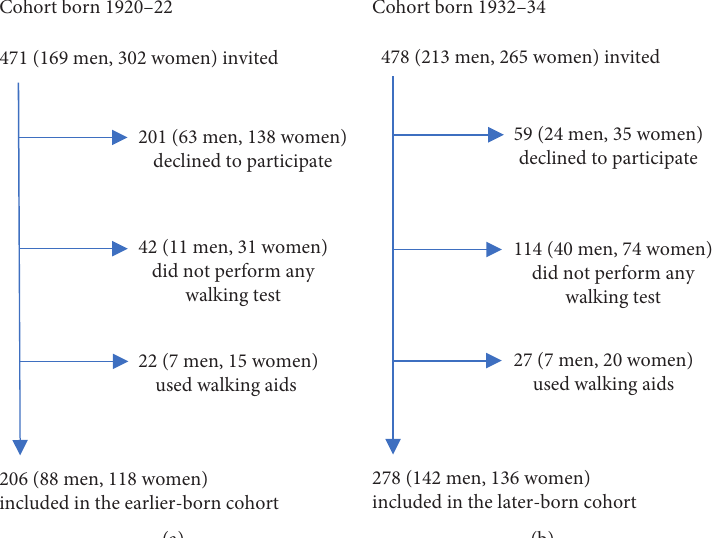
Figure 1: Flow sheet explaining the enrolment of men and women in the (a) first cohort born 1920–22 and in the (b) second cohort born